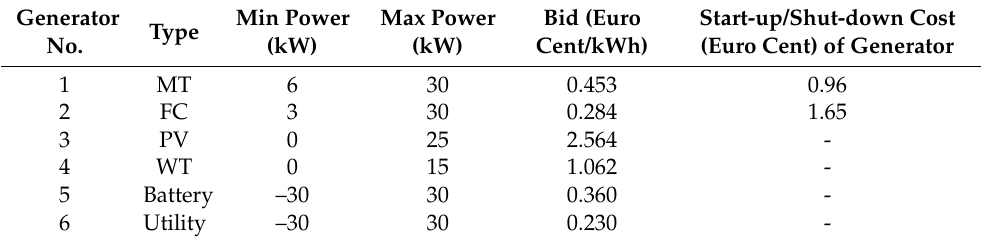
Table 2. Rating of distributed generation.